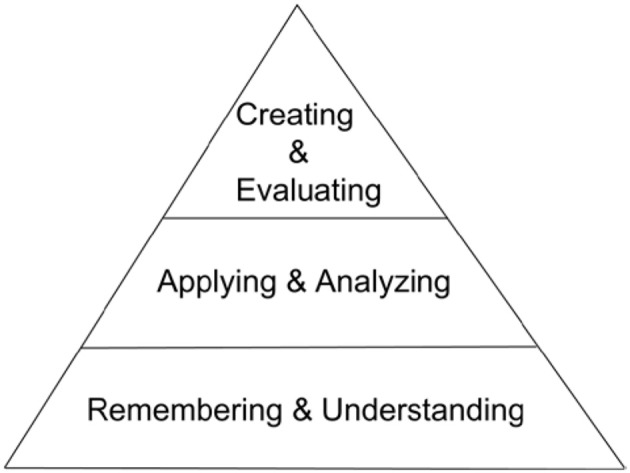
A simplified revised Bloom's Taxonomy of Educational Objectives.